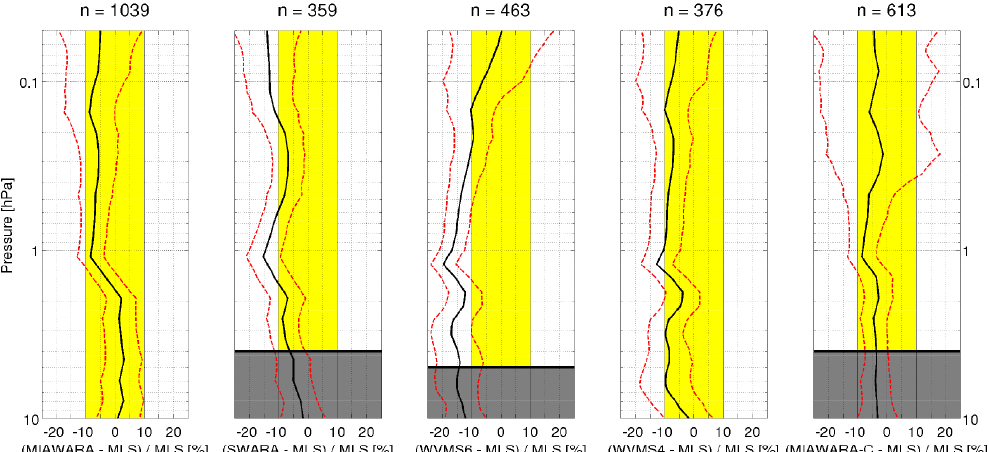
Figure 2. Same as Fig. 1 but for the winter season (NH), considering the following months in the period from August 2010 to